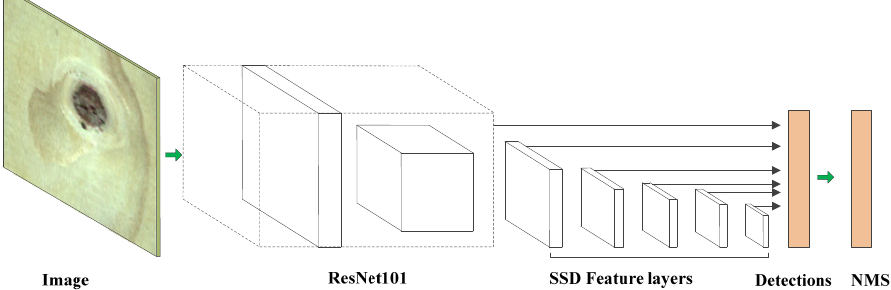
Figure 7. Improved SSD network framework based on the ResNet network.